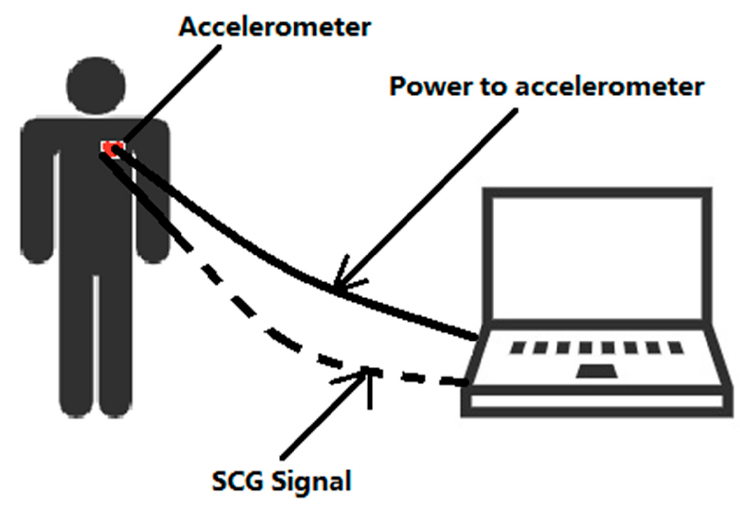
Figure 2. A schematic of SCG measurement device.